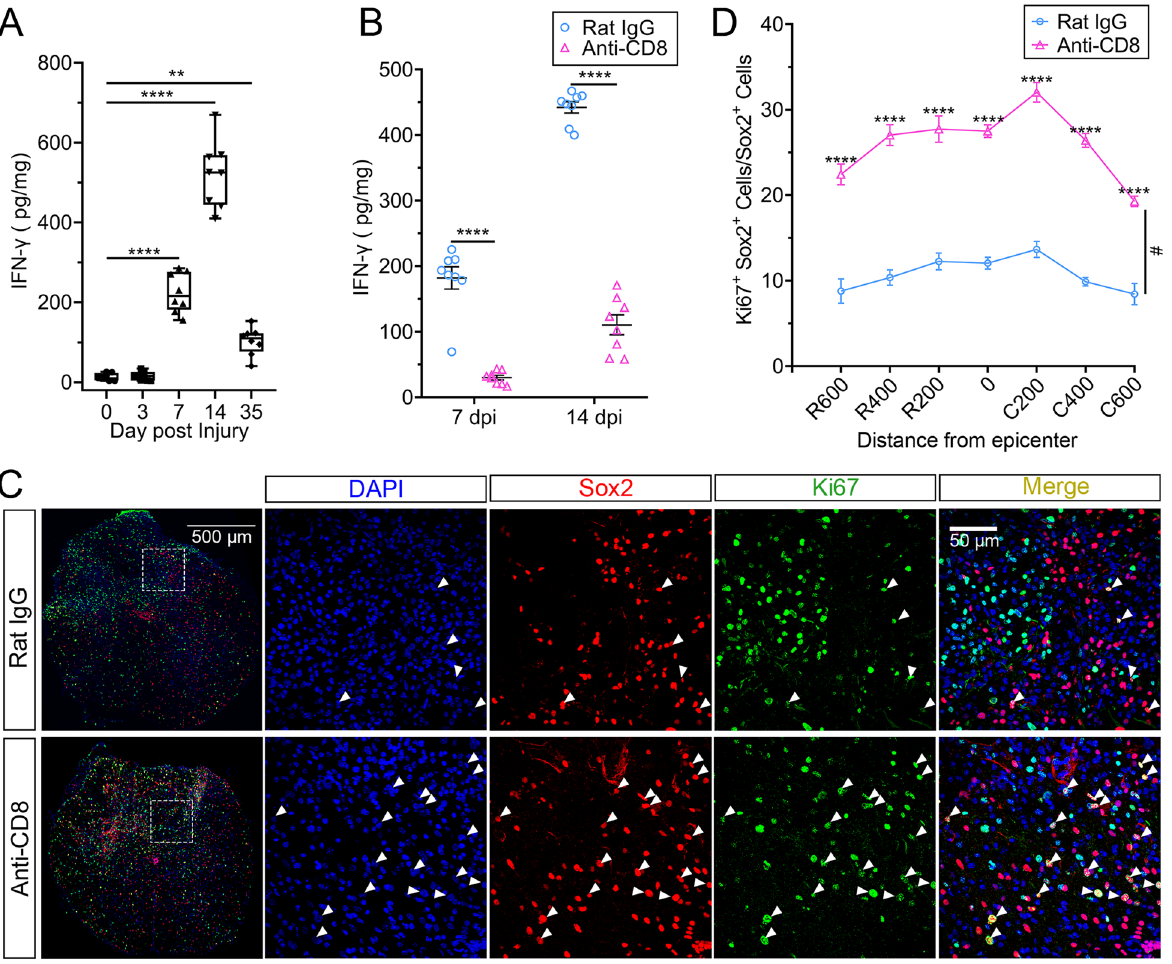
Fig. 6 CD8 + T cells inhibited NSC proliferation in vivo. A Elisa analysis showing the level of IFN‑γ at 0, 3, 7, 14, and 35 dpi after SCI, n **** P < 0.0001, one‑way ANOVA with Tukey. B Elisa analysis showing the level of IFN‑γ after the administration of an anti‑CD8 antibody at 7 and 14 dpi. Equal rat IgG was used for control, n 8, **** P < 0.0001, one‑way ANOVA with Tukey. C Immunofluorescence staining showing the change of = proliferating NSCs with or without the administration of an anti‑CD8 antibody after SCI at 7 dpi. Scale bar, 500 μm or 50 μm. D A statistical graph of C . n 4. **** P < 0.0001, # P < 0.05, two‑way ANOVA‑RM with =